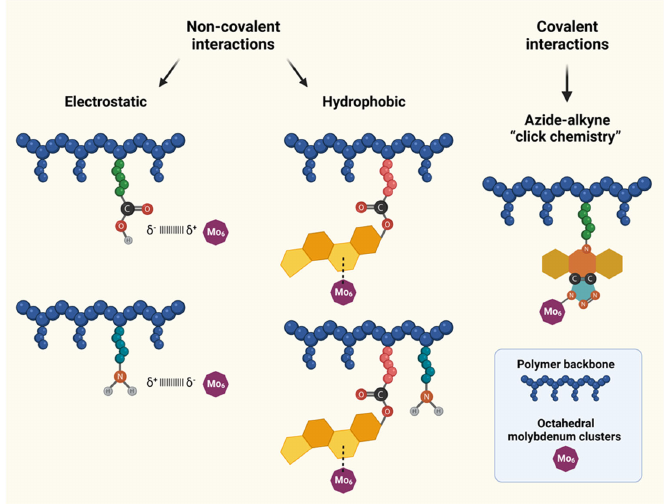
Figure 1. Schematic representation of non ‐ covalent and covalent interaction approaches employed for binding of Mo 6 clusters to polymer precursors; Mo 6 cluster not ‐ to ‐ scale.